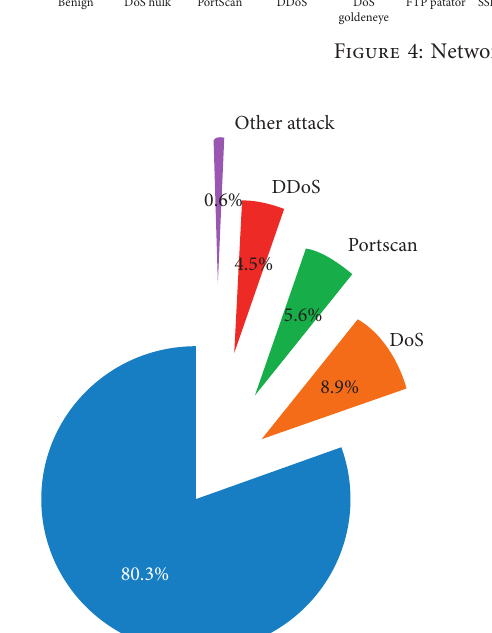
Figure 5: Complete CICIDS2017 dataset distribution.